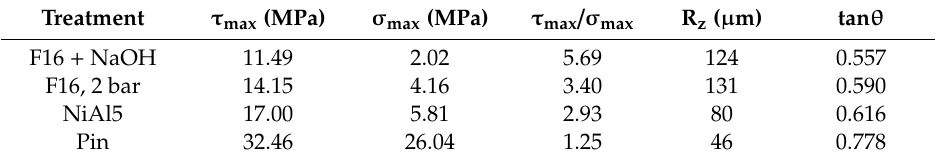
Table 8. Interlaminar strength and roughness parameters (2 µ m tip) of hollow cylinder specimens.